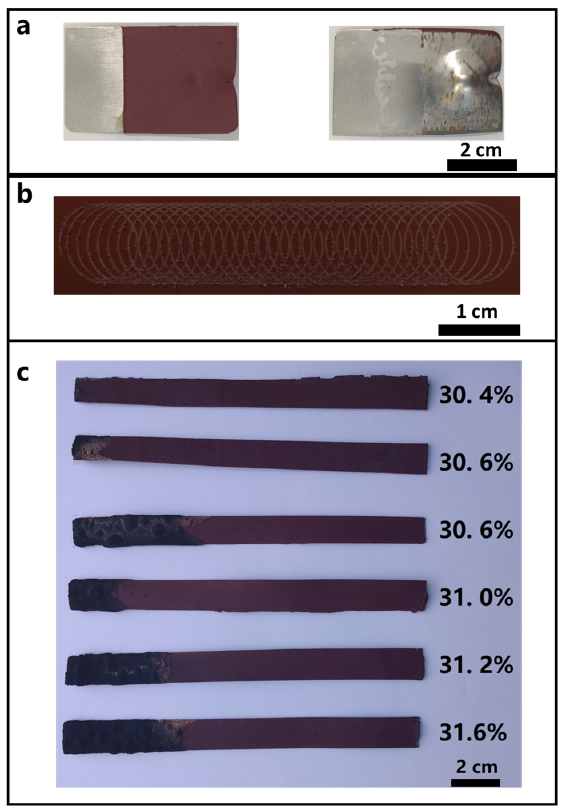
Figure 7. Test of the flame-retardant coating with a mixing ratio of RP 10 wt.% and ATH 20 wt.%: ( a ) 100 cm drop hammer anti-impact performance test; ( b ) adhesion performance test; ( c ) determi- nation of LOI value.